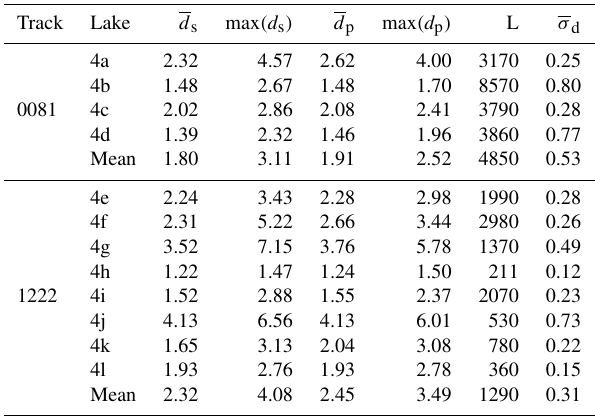
Table 2. As with Table 1, but for ICESat-2